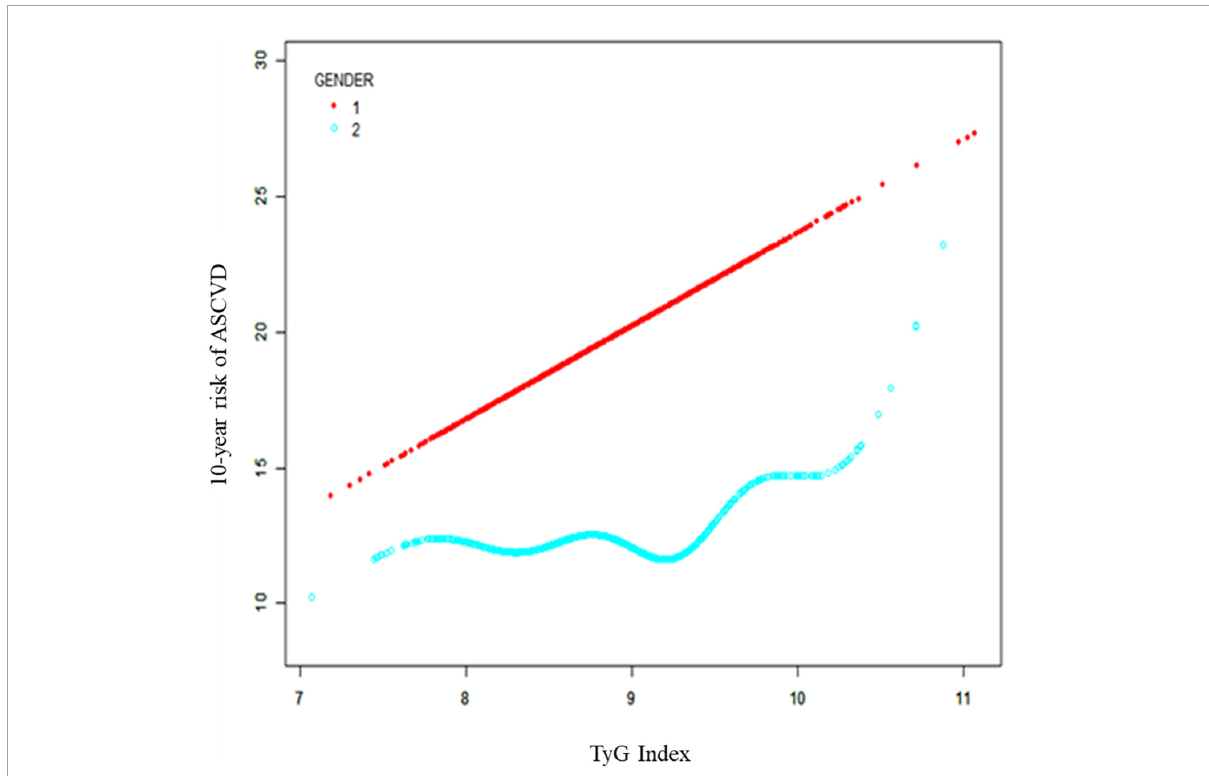
FIGURE2 Subgroup analysis stratified by gender between TyG index and 10-year risk of a first hard ASCVD event. Age, race, body mass index, systolic blood pressure, diastolic blood pressure, hypertension treatment, smoking, diabetes, and low-density lipoprotein cholesterol were adjusted. ASCVD, atherosclerotic cardiovascular disease; TyG, triglyceride-glucose.